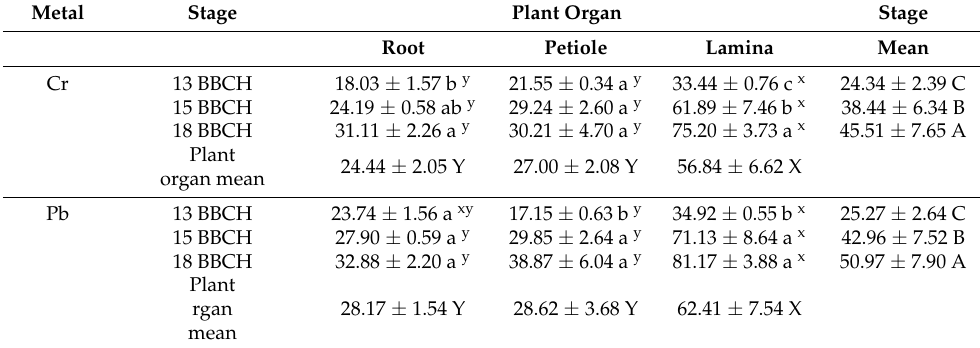
Table 6. Cr and Pb concentrations in different plant organs and development stages of S. perfoliatum .